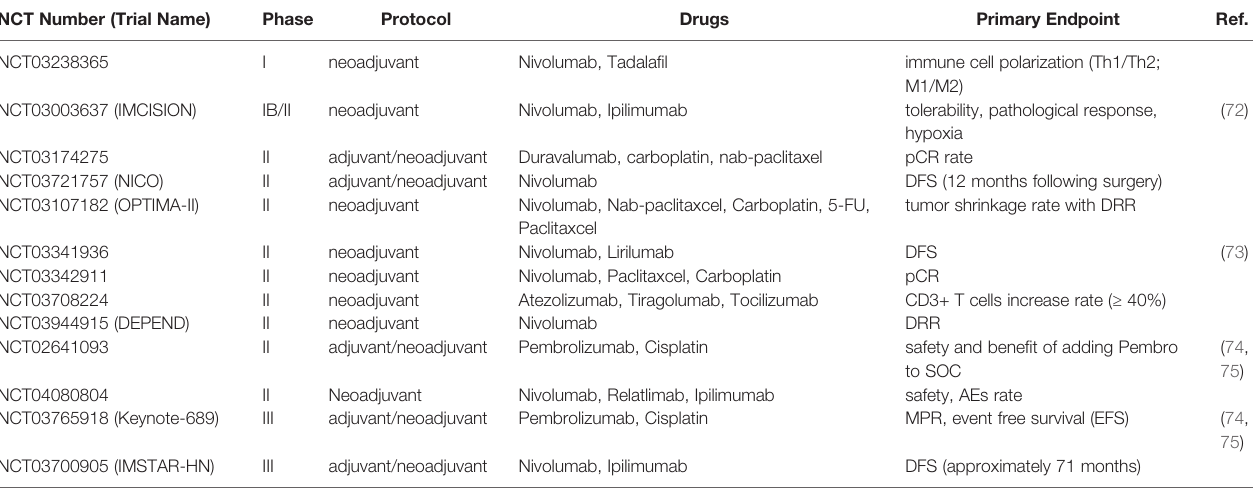
TABLE 2 | Ongoing neoadjuvant immunotherapy clinical